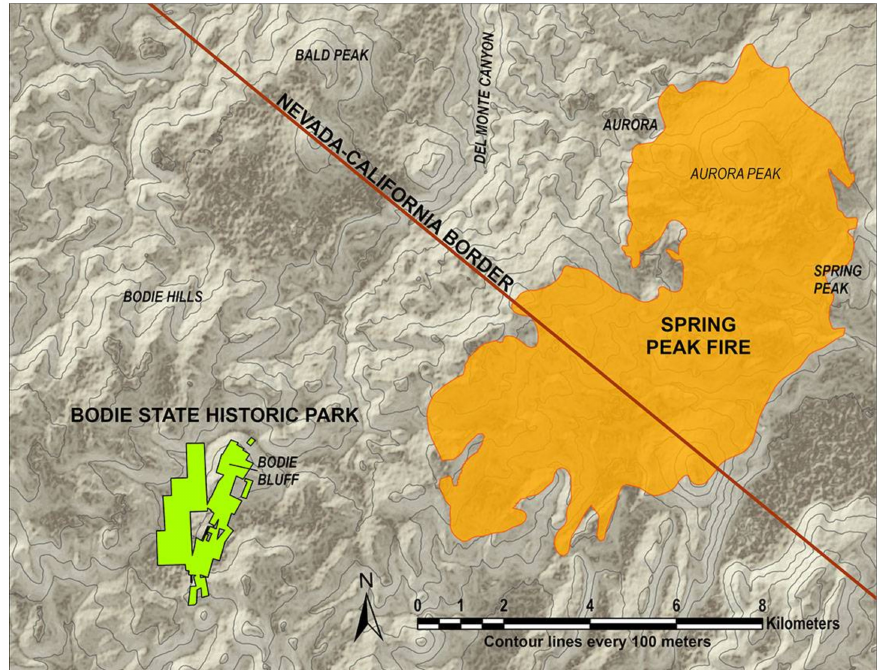
Figure 4. Map showing the Spring Peak Fire’s perimeter (orange) and proximity to the Bodie State Historic Park’s boundaries (green). Generated from data made available by the U.S. Forest Service, California State Parks, and NASA JPL (2021). NASADEM Merged DEM Global 1 arc second V001. Distributed by OpenTopography. https://doi.org/10.5069/G93T9FD9 Accessed: 23 August 2021. Map by A.